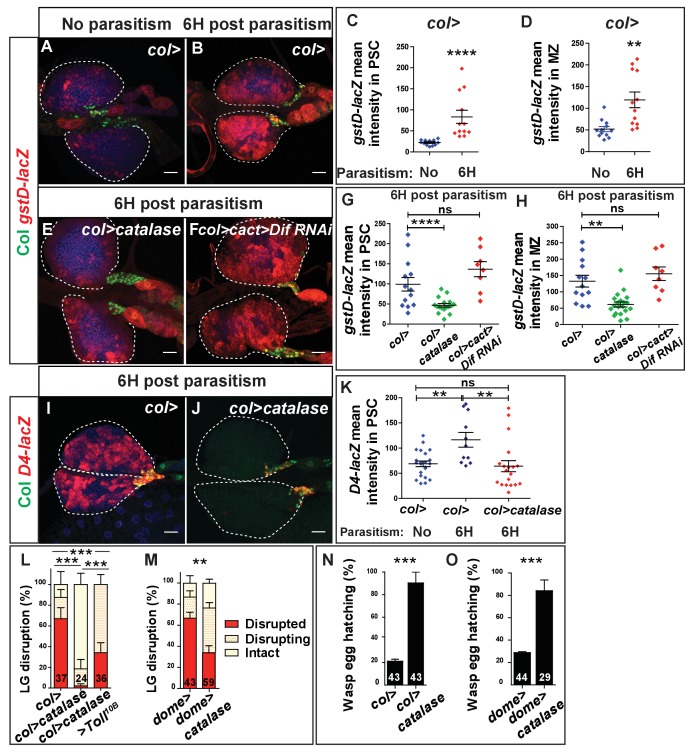
Wasp-mediated oxidative stress promotes Toll/NF-kB activation in the PSC and lymph gland disruption.(A, B, E, F) LacZ (red) and Col (green) immunostaining in gstD-lacZ expressing lymph glands in wt context (col>; A, B), when Catalase is expressed in the PSC (col > catalase) (E) and when Toll/NF-kB is inactivated in PSC cells (col > cact > Dif RNAi)(F). (C, D, G, H) Quantifications of gstD-lacZ mean intensity in PSC and progenitor (MZ) cells. Error bars represent SDs. **p<0.01, ****p<0.0001 and ns (not significant) (Mann-Whitney nonparametric test). (I, J) LacZ (red) and Col (green) immunostaining in D4-LacZ expressing lymph glands in wt (col>) (I) and when an intracellular catalase is expressed in the PSC (col > catalase) (J). (K) Quantifications of D4-lacZ mean intensity in PSC cells. **p<0.01 and ns (not significant) (Mann-Whitney nonparametric test). (L–M) Quantifications of lymph gland disruption post parasitism. (N,O) Quantification (%) of wasp egg hatching. Error bars correspond to SEM, **p<0.01, ***p<0.001 (Pearson’s Chi-squared test).10.7554/eLife.25496.035Figure 6—source data 1.gstD-lacZ staining quantification.10.7554/eLife.25496.036Figure 6—source data 2.D4-lacZ staining quantification.10.7554/eLife.25496.037Figure 6—source data 3.Lymph gland disruption quantification.10.7554/eLife.25496.038Figure 6—source data 4.Lymph gland disruption quantification.10.7554/eLife.25496.039Figure 6—source data 5.Wasp egg hatching quantification.